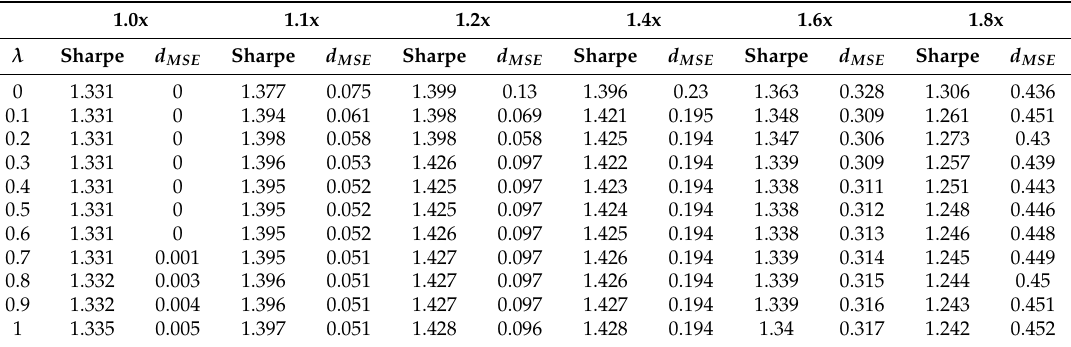
Table 5. Single period with increasing return multiplier and penalty value λ